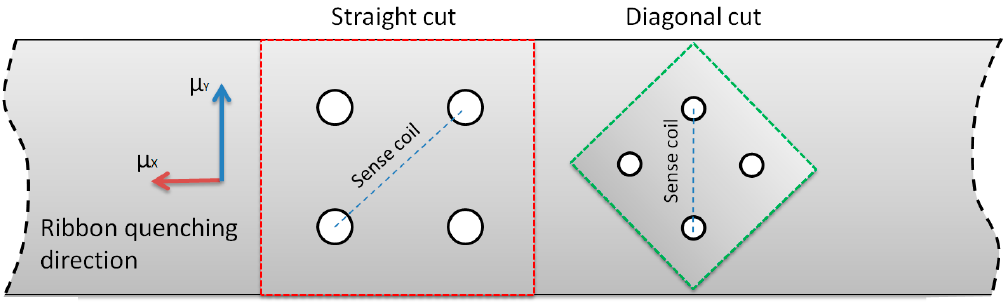
Figure 5. Schematic of ‘straight’ and ‘diagonal’ cut tensductor sensors.